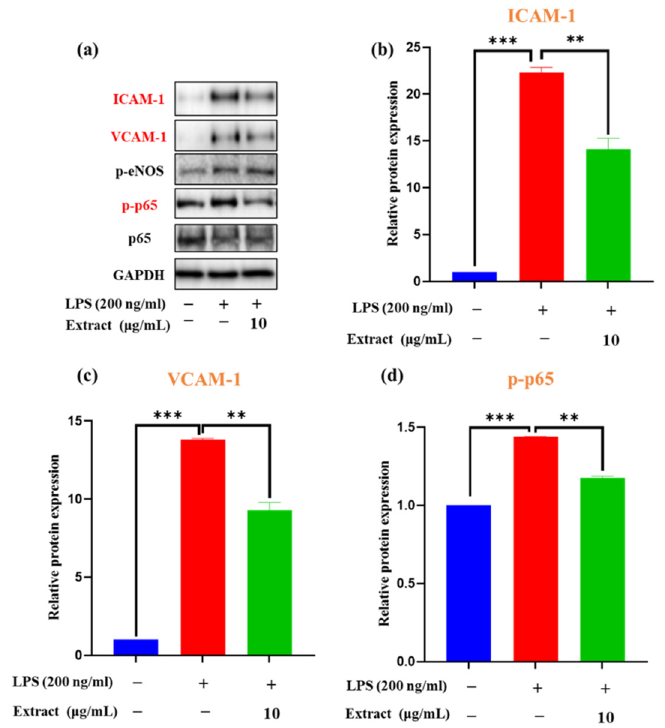
Figure 1. Effects of A. quinata extract on LPS-induced HUVEC activation and expression of ( a ) adhesion molecules and Nuclear factor-kappa B (NF- κ B) signaling pathway-related factors of p-p65; the relative protein expression of ( b ) ICAM-1, ( c ) VCAM-1, and ( d ) p-p65. The experiment was repeated three times and similar results were acquired. Data are expressed as the means ± SDs. ** p < 0.01 vs. the LPS-treated group, *** p < 0.001 vs. the control cell group.